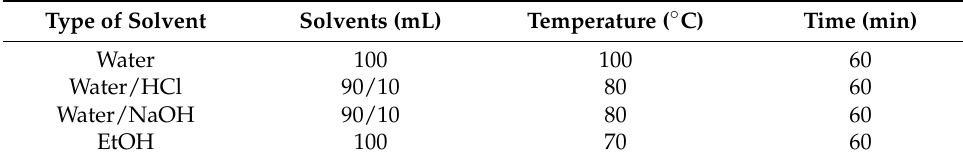
Table 1. Experimental parameters for